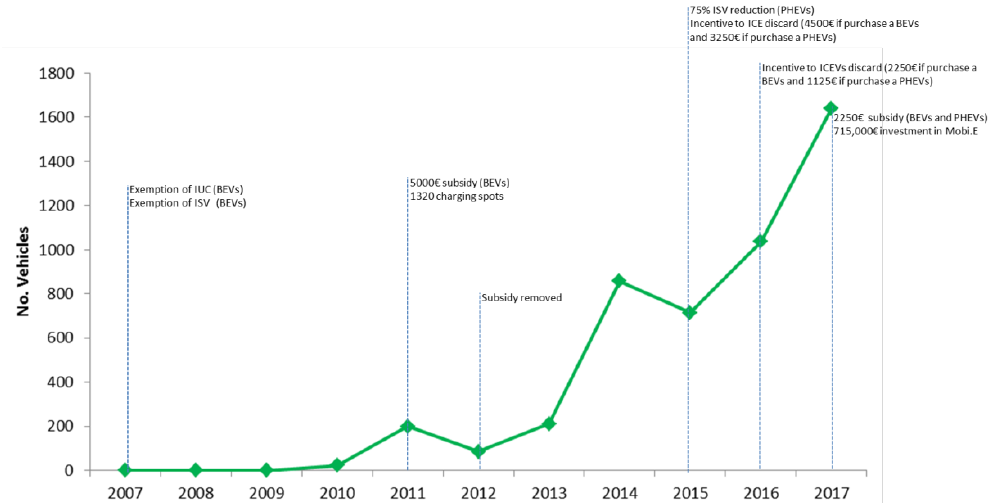
Figure 9. Sales of plug-in electric vehicles crossed with Portuguese government incentives for electric mobility (IUC = circulation tax; ISV = vehicle purchase tax).